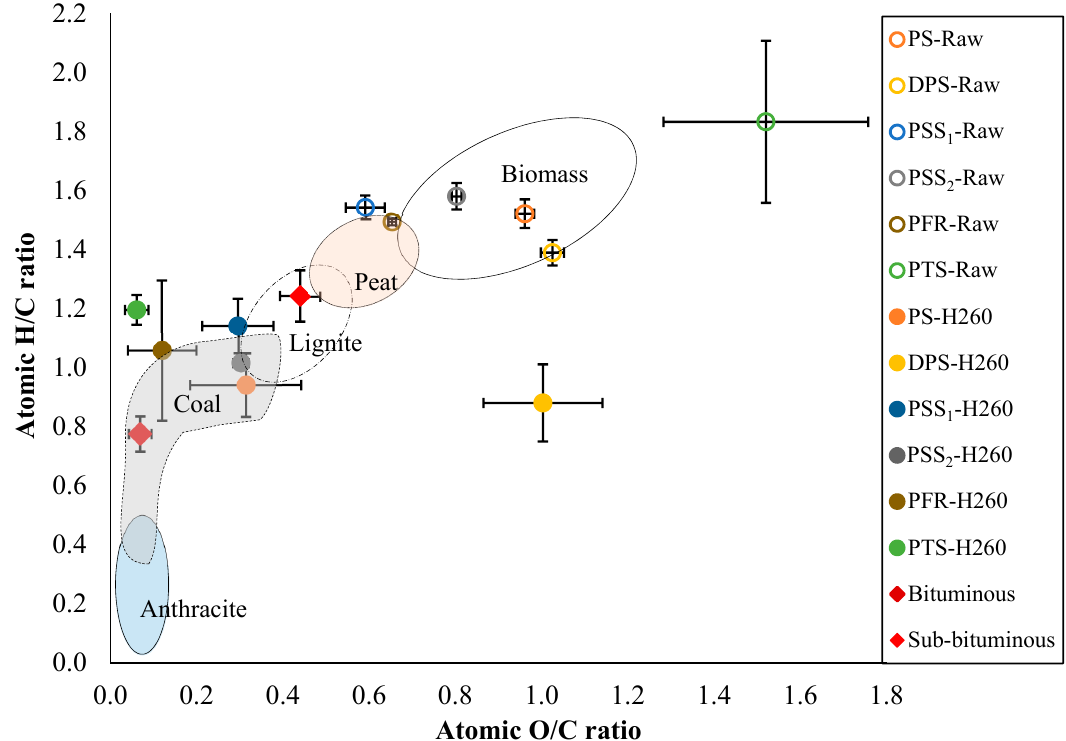
Figure 1. van-Krevelen diagram for all raw and hydrochar samples including bituminous and Figure 1. van ‐ Krevelen diagram for all raw and hydrochar samples including bituminous and sub ‐ sub-bituminous bituminous coal.